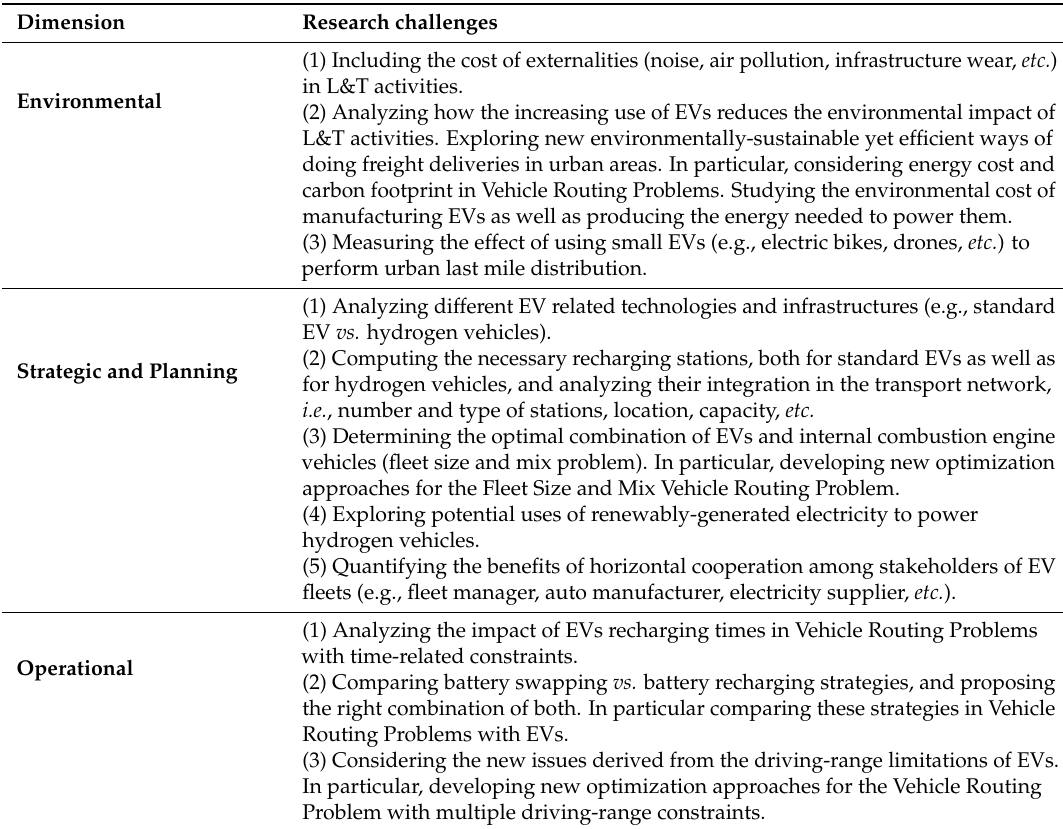
Figure 1. Evolution of electric vehicle (EV) related publications in Scopus-indexed journals. Table 1. Open Operations Research/Computer Science (OR/CS) research challenges associated with the use of EVs.